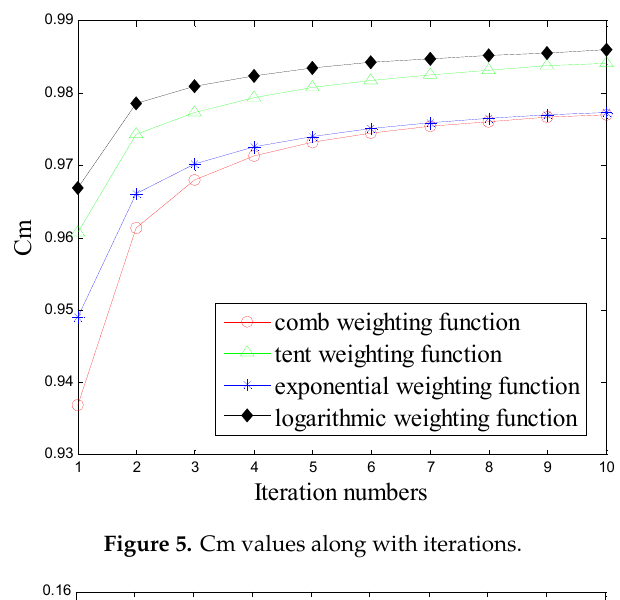
Figure 5. Cm values along with iterations.